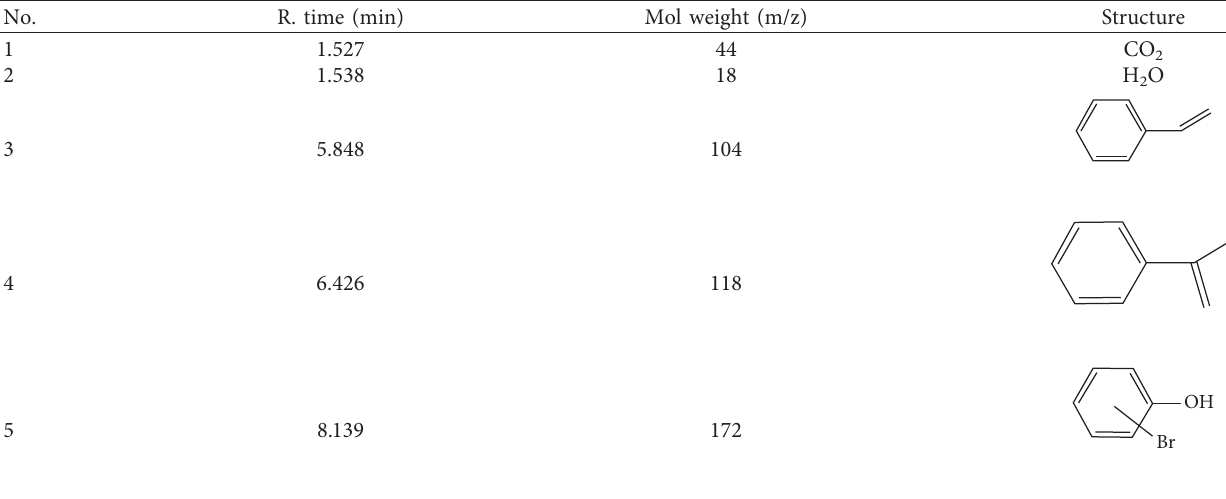
Table 4: Structure of pyrolytic products of the